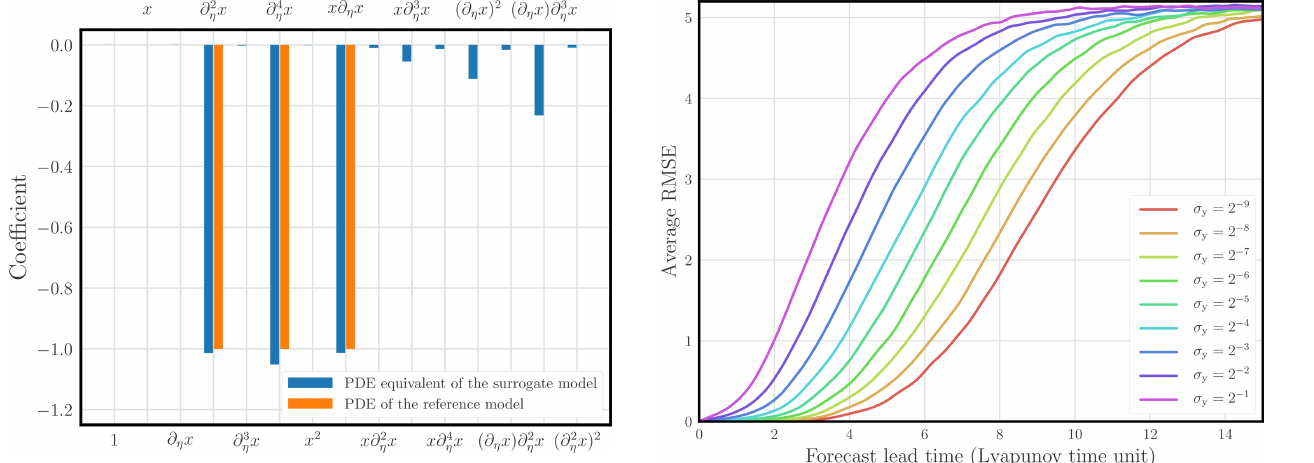
Figure 7. Average RMSE of the surrogate model (L96 with an RK4 structure) compared to the reference model (L96 with an RK4 inte- gration scheme) as a function of the forecast lead time (in Lyapunov time unit) for a range of observation error standard deviations σ y